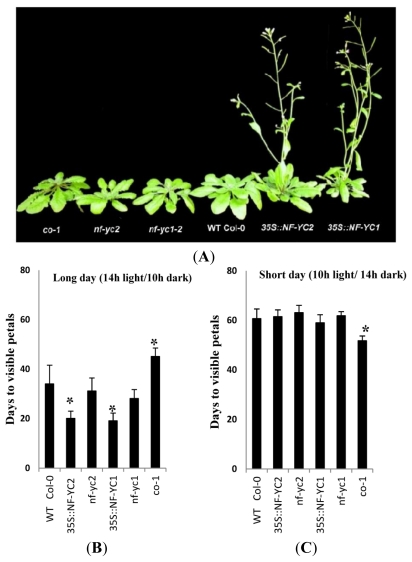
(A) Developmental stage and flowering phenotype of Arabidopsis wild-type (Col-0), nf-yc2, nf-yc1-2, co-1 and representatives of transgenic lines overexpressing ectopically NF-YC2 or NF-YC1 38 days after germination. Expression of 35S::NF-YC1 and 35S::NF-YC2 leads to induction of early flowering under long day condition in comparison to wild-type plants (B). Time period between germination and development of first visible petals is indicated under long day (B) or short day condition (C).